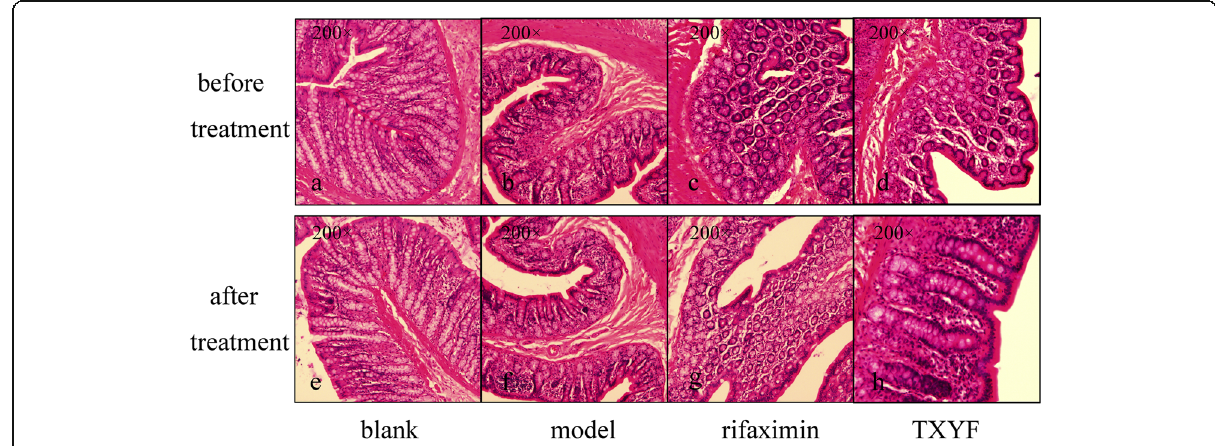
Fig. 2 Histological examination of the intestinal mucosal barrier. a - d One day before treatment; e - h after 2 weeks of